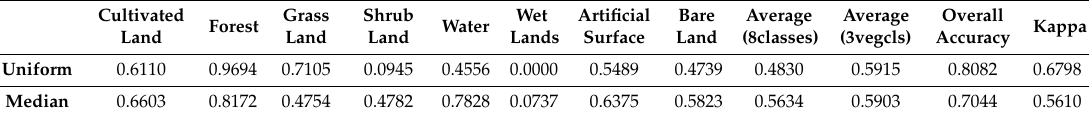
Table 5. Accuracy (uniform and median weights, Slovenia—8 classes).